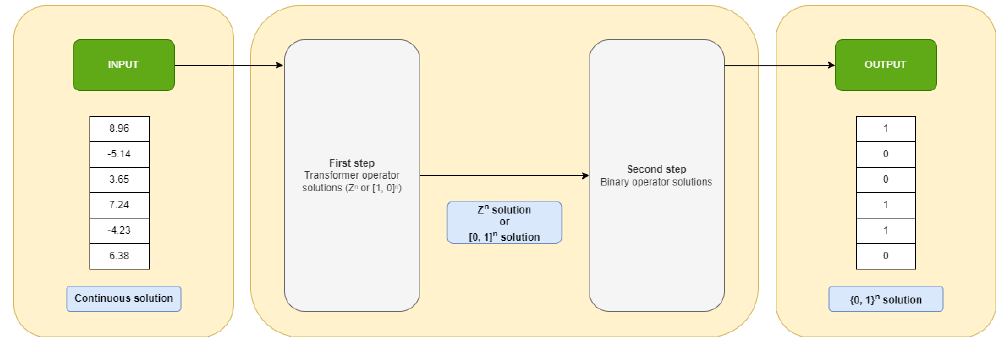
Figure 7. Simple Transformation − Sequential